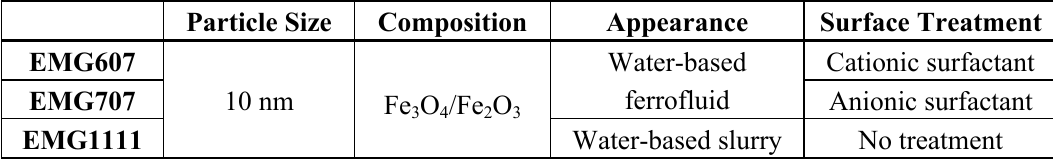
Table 1. Characteristics of magnetic nanoparticles used in the experiment.